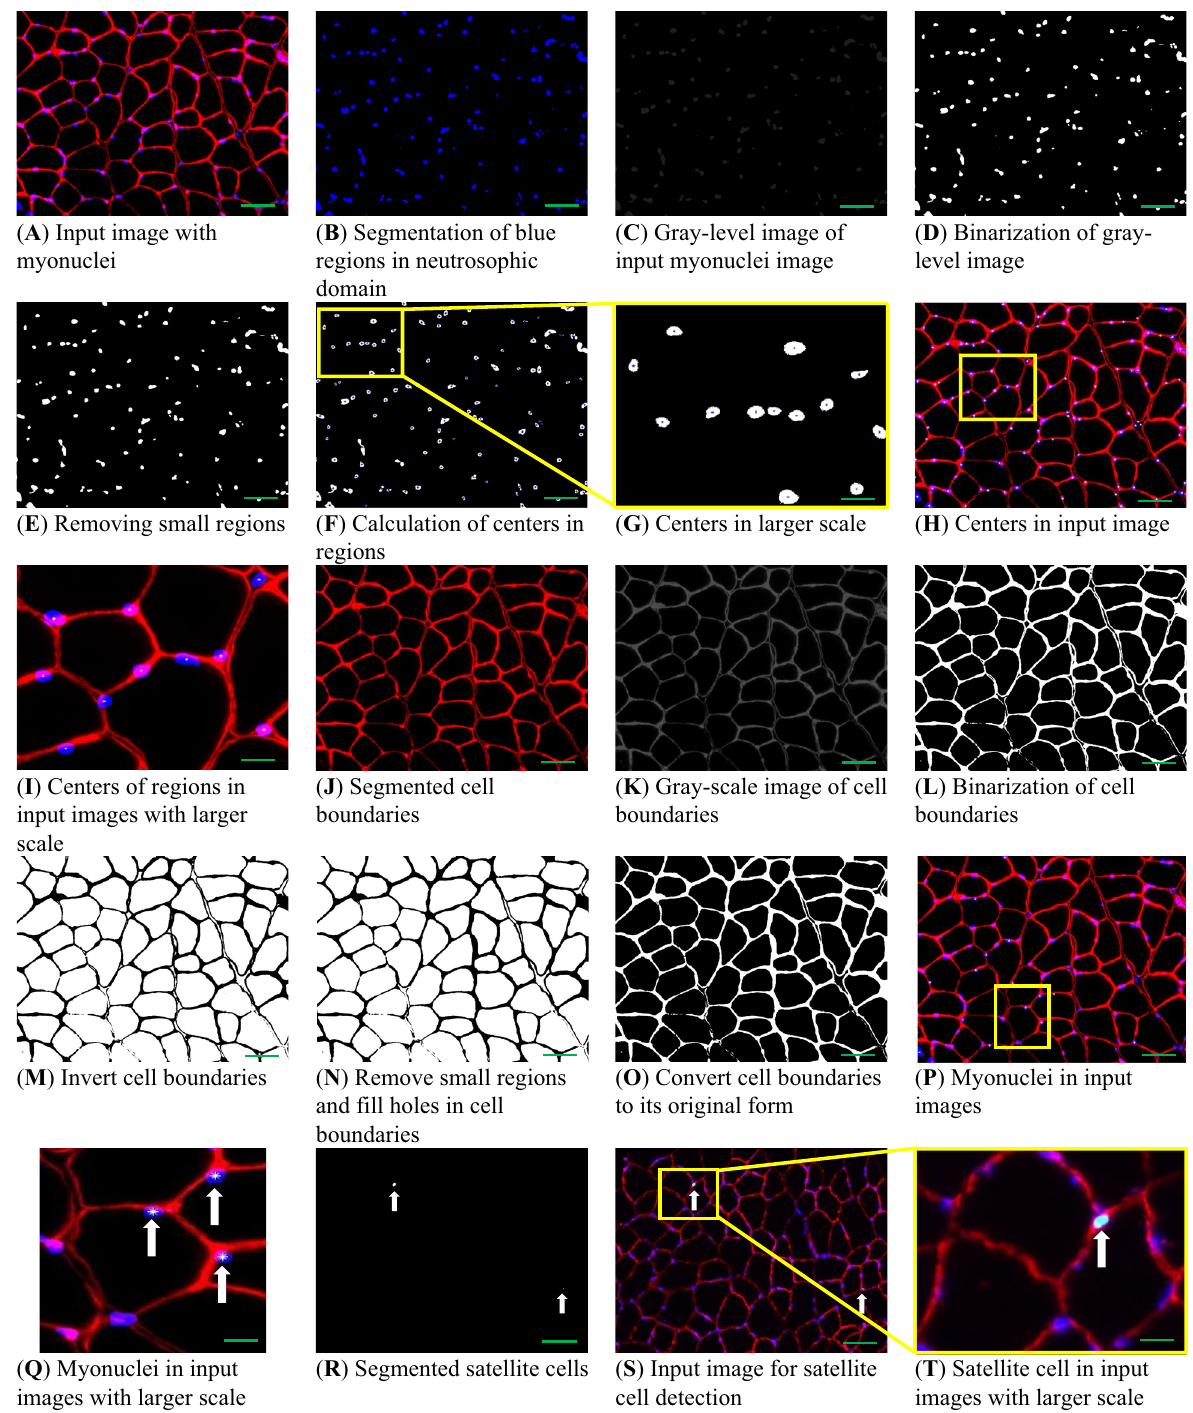
Figure 8. MyoView workflow for myonuclei and satellite cell detection. ( A ) When the MyoView software starts, a window automatically opens to select the image to be analyzed. ( B-Q ) Represent detection process for myonuclei. ( R-T ) Represent detection process for satellite cells. Higher magnification of selected area is shown in yellow box. Bars = 250